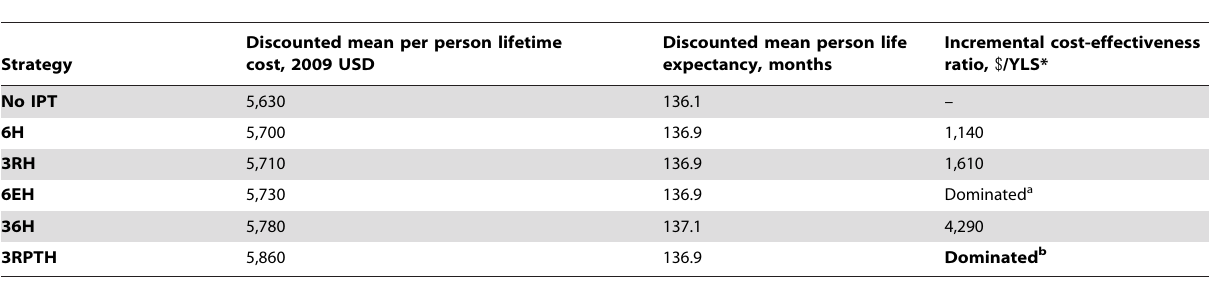
Table 6. Incremental cost-effectiveness of additional strategies for TB preventive therapy.